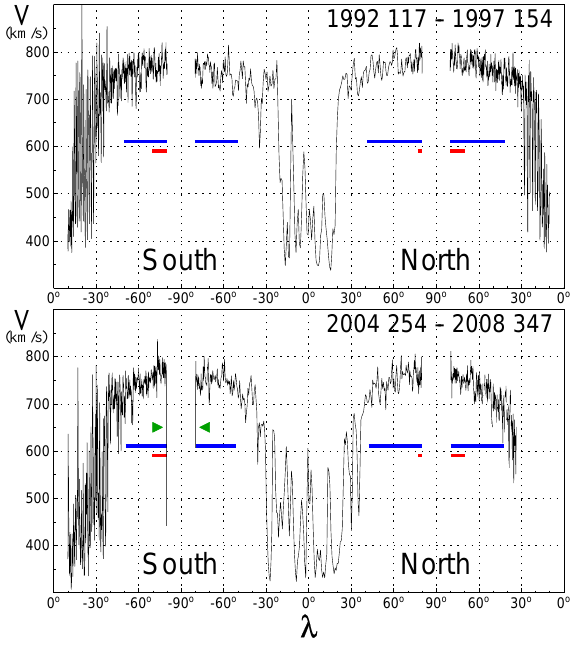
Fig. 1. Magnitude of the solar wind velocity V vs. latitude λ during the first (top) and third (bottom) out-of-ecliptic orbit of Ulysses. Zero latitude at the left and right ends corresponds to the near- aphelion solar equator crossing, that in the center is for the near- perihelion crossing. Blue and red horizontal segments indicate the analysed intervals (see text). The velocity decrease highlighted by green arrows in the bottom panel is caused by the tail of comet Mc- Naught.